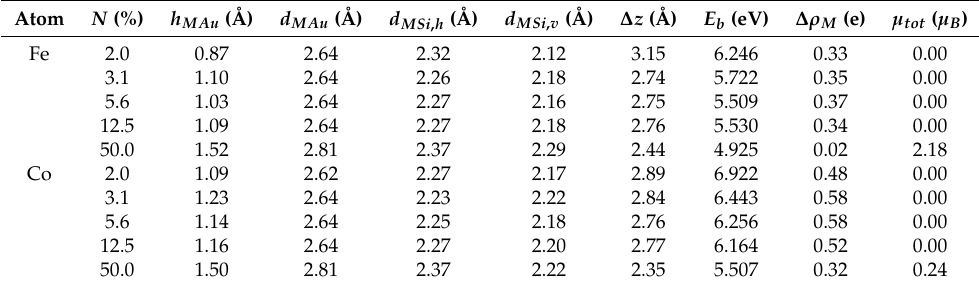
Table 1. Calculated structural and energetic parameters for Au-supported planar silicene with adsorbed Fe and Co at their different coverages N : the height of the adatom over the Au plane ( h MAu ), the bond length between the adatom and its nearest Au atoms ( d MAu ), the bond length between the adatom and its nearest Si atoms in the plane ( d MSi , h ), the bond length between the adatom and the underneath Si atom ( d MSi , v ), thickness of the silicene/Au structure defined as the difference between the largest and smallest z coordinates of Si and Au atoms ( ∆ z ), the binding energy of adatoms on silicene/Au ( E b ), charge transferred from silicene to adatom ( ∆ ρ M ), total magnetic moment of the system ( µ tot ) in units of Bohr magneton ( µ B